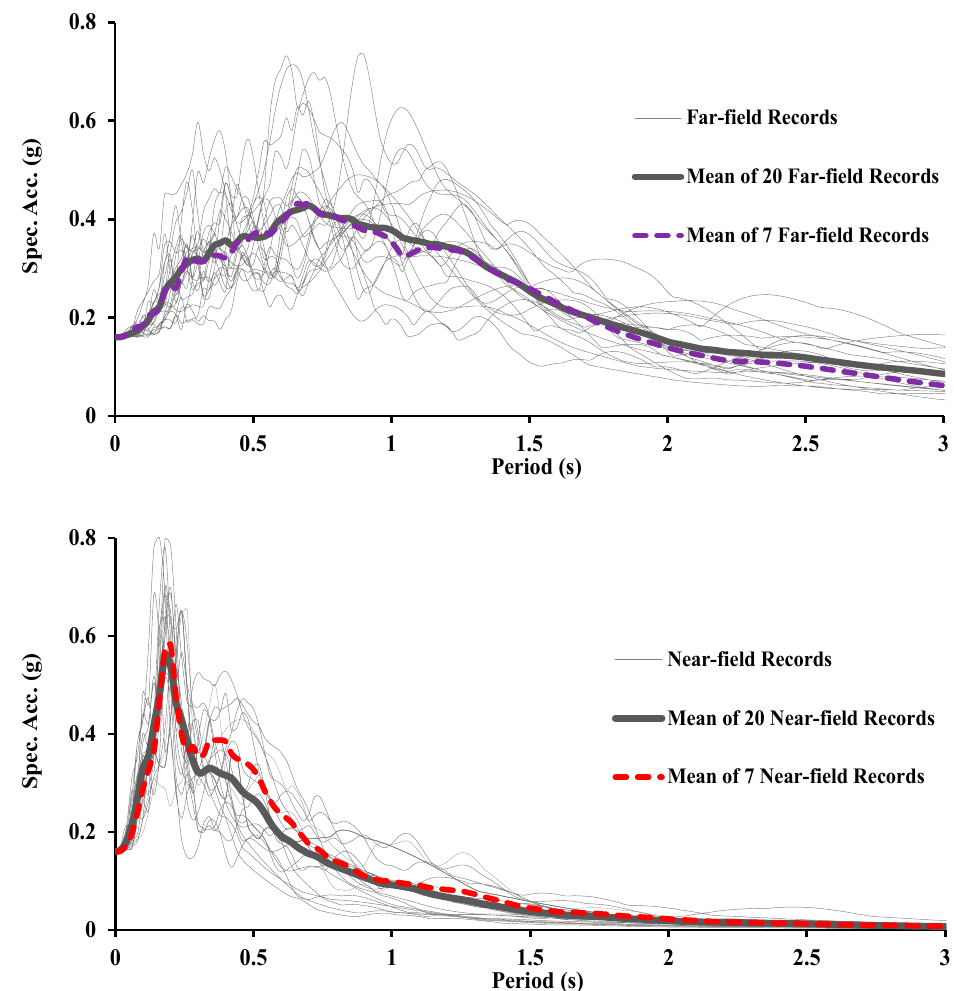
Figure 14. Acceleration response spectra of the selected far-field earthquake record ( top ) and near- source ground motions ( bottom ) scaled to the design earthquake intensity.